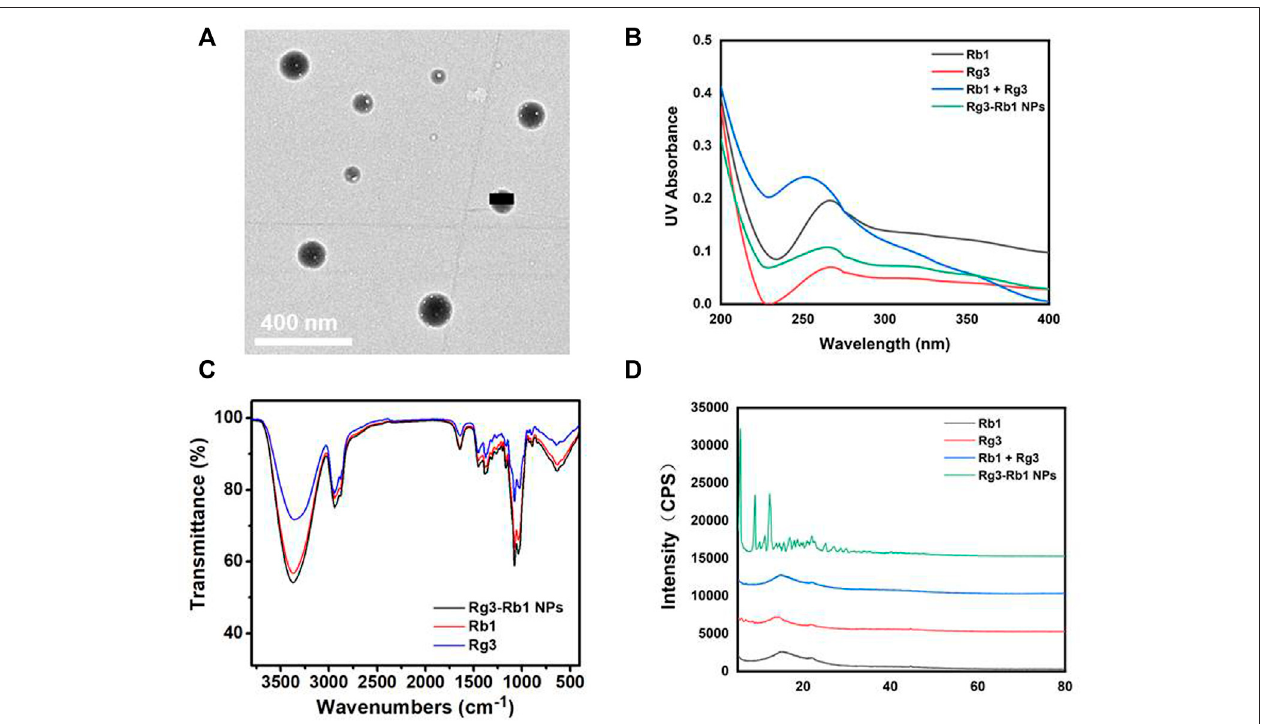
FIGURE 1 | Characterizations of Rg3-Rb1 NPs. (A) TEM image of Rg3-Rb1 NPs. Scale bar = 400 nm. (B) UV-vis of Rb1, Rg3, Rb1+Rg3, and Rg3-Rb1 NPs. (C) FTIR of Rb1, Rg3, and Rg3-Rb1 NPs. (D) XRD spectra of Rb1, Rg3, Rb1+Rg3, and Rg3-Rb1 NPs. FTIR, Fourier-transform infrared spectroscopy; NPs, nanoparticles; TEM, transmission electron microscopy; UV, ultraviolet; XRD, X-ray diffraction.